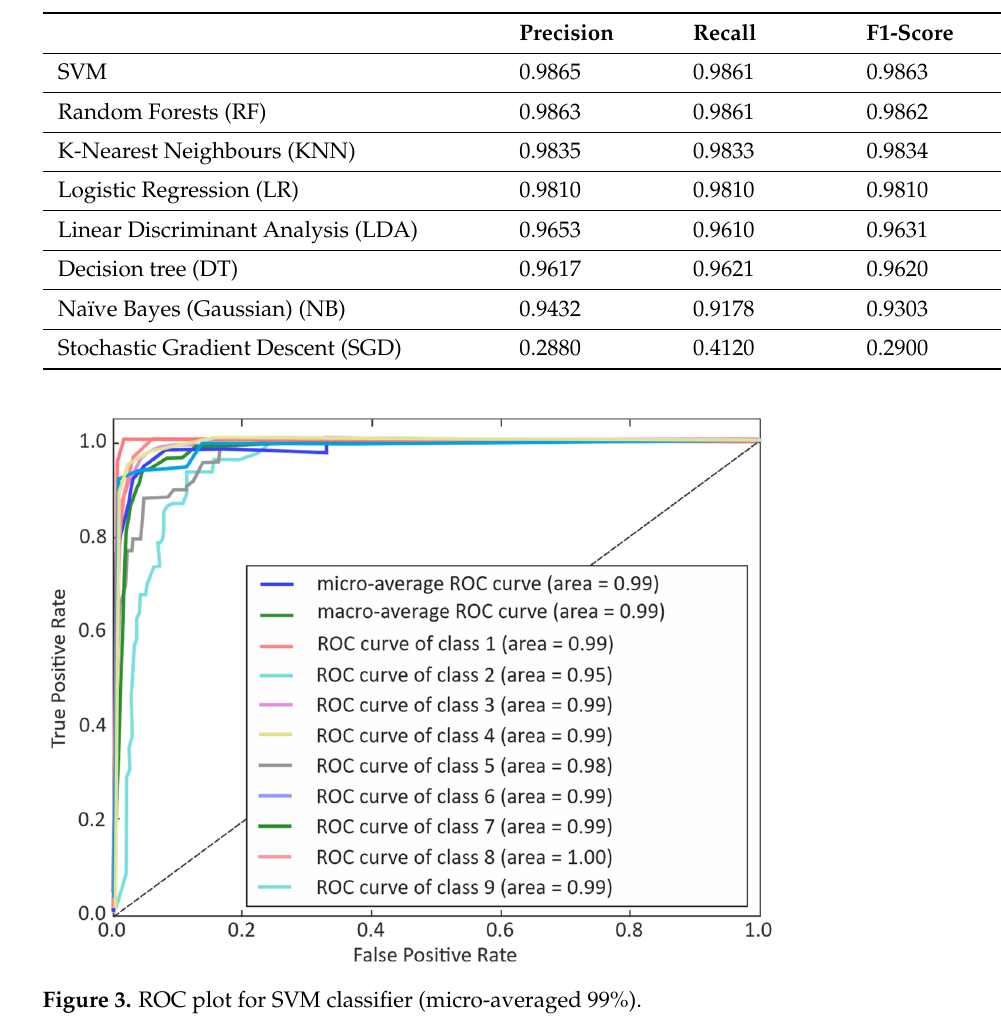
Figure 5. ROC plot for LR classifier (micro-averaged 99%).